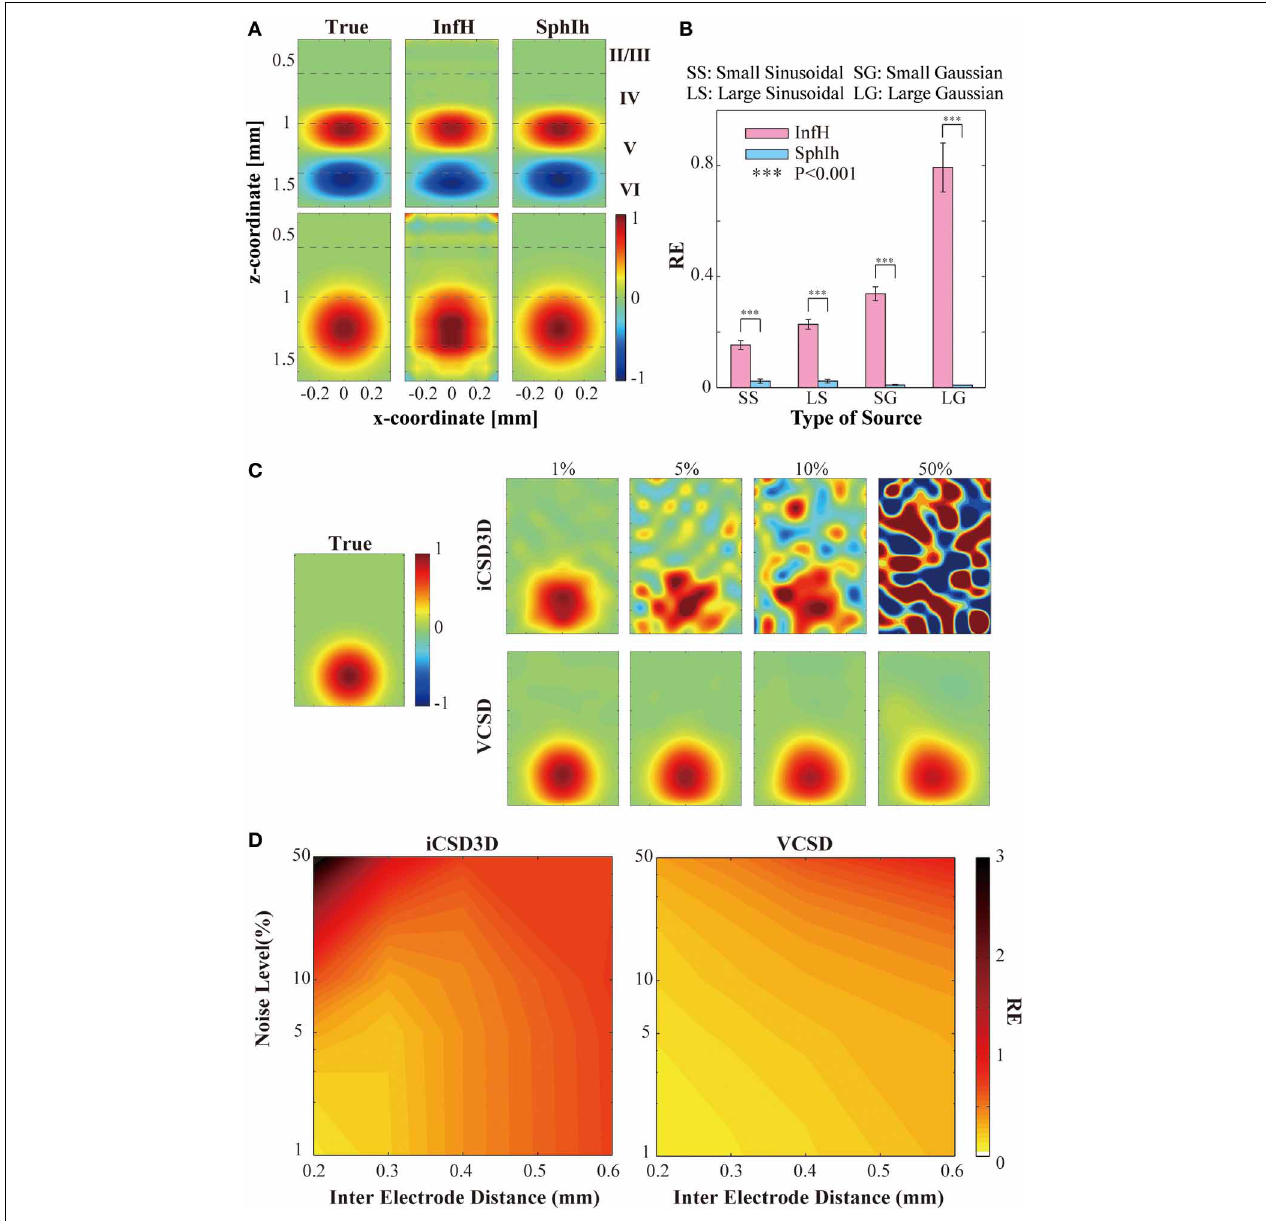
FIGURE 7 | Results of the simulations studies to evaluate the vCSD method. (A) Example of the CSD reconstructions of large-sized sinusoidal and Gaussian types of CSD of distributions by vCSD method using both InfH and SphIh volume conductor models. The dashed lines in each panel indicates the boundaries separating the cortical layers. (B) Statistical test to evaluate the reconstruction errors (REs) for InfH and SphIh volume conductor models. The triple asterisk indicates the threshold of the p -value ( P = 0 . 001, n = 10) used for the one-tailed t -test.